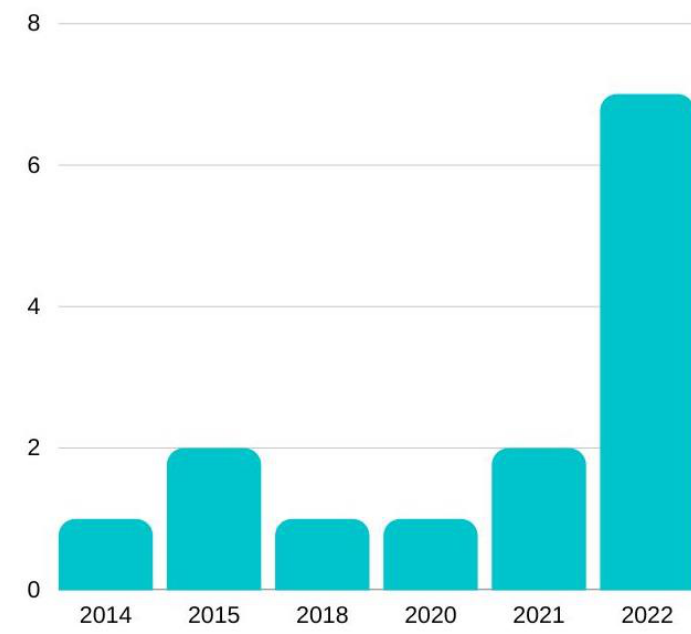
Figure 2. Distribution of studies by year of publication.